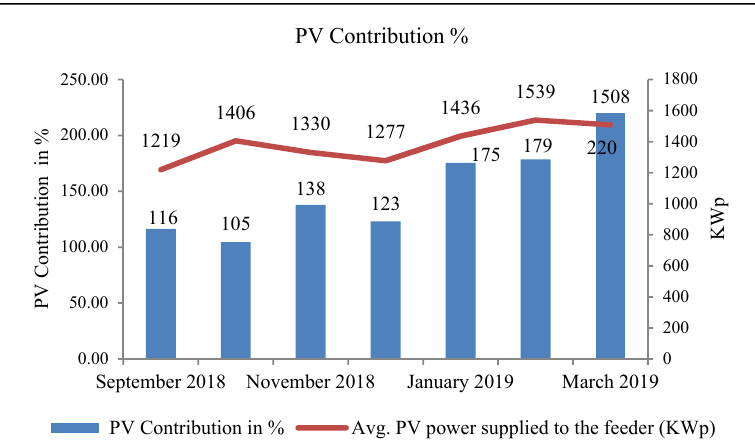
Figure 10. PV Contribution of the Months.